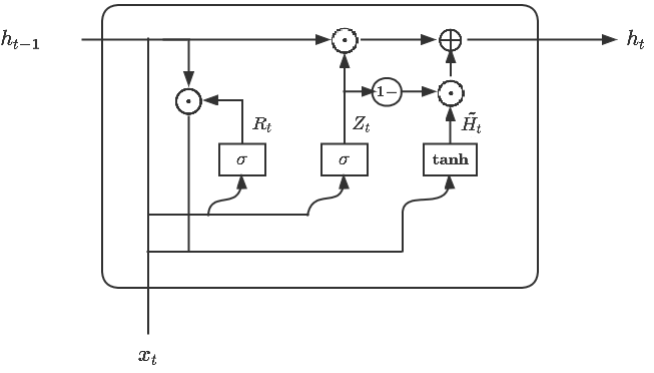
Figure 4. Entire process framework for GRU.